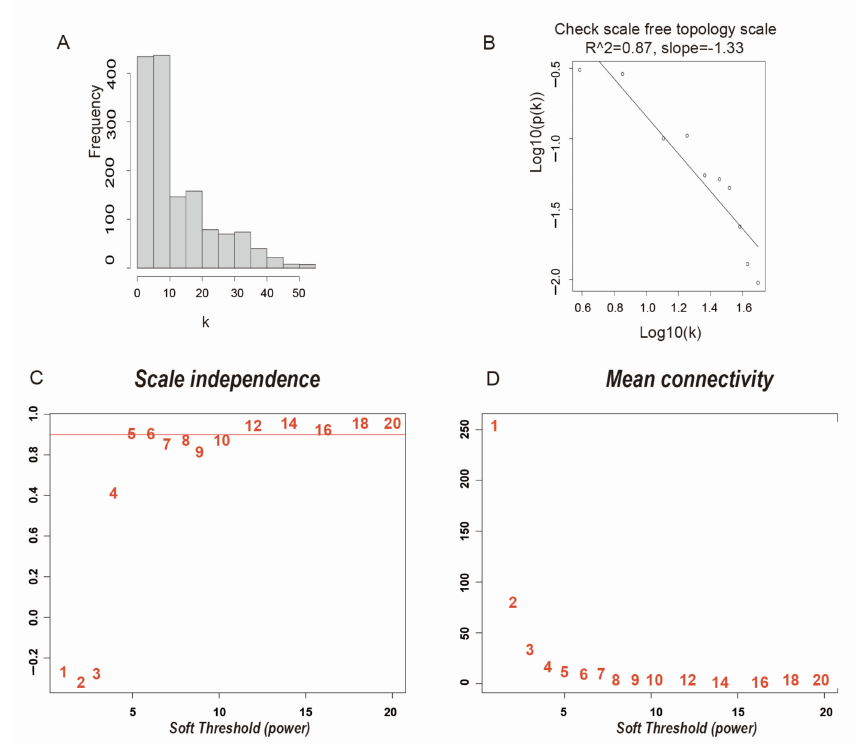
Figure 3. Weighting coefficient β selection. ( A ) Plot of scale-free fit index. ( B ) Plot of different soft-thresholding powers with different mean connectivity. ( C ) Connectivity distribution of nodes with β set as 5. ( D ) The verification of scale-free topology with β set as